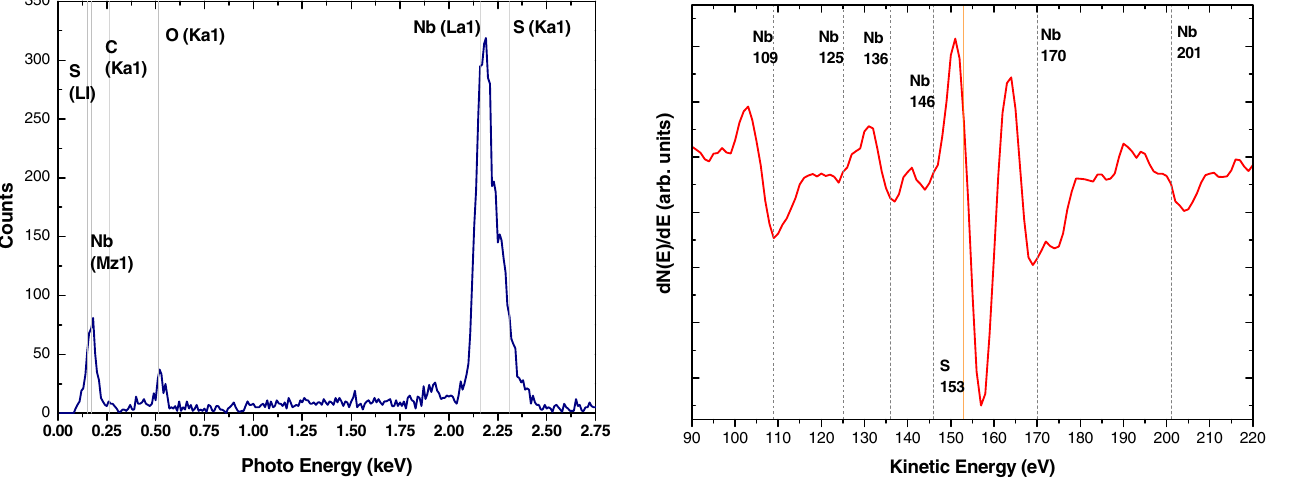
FIG. 7. AES spectrum observed on spot 1. The theoretical sulfur peak position is labeled in orange. The Nb:S atomic ratio is 3:1 after RBD Instruments Augerscan TM quantification